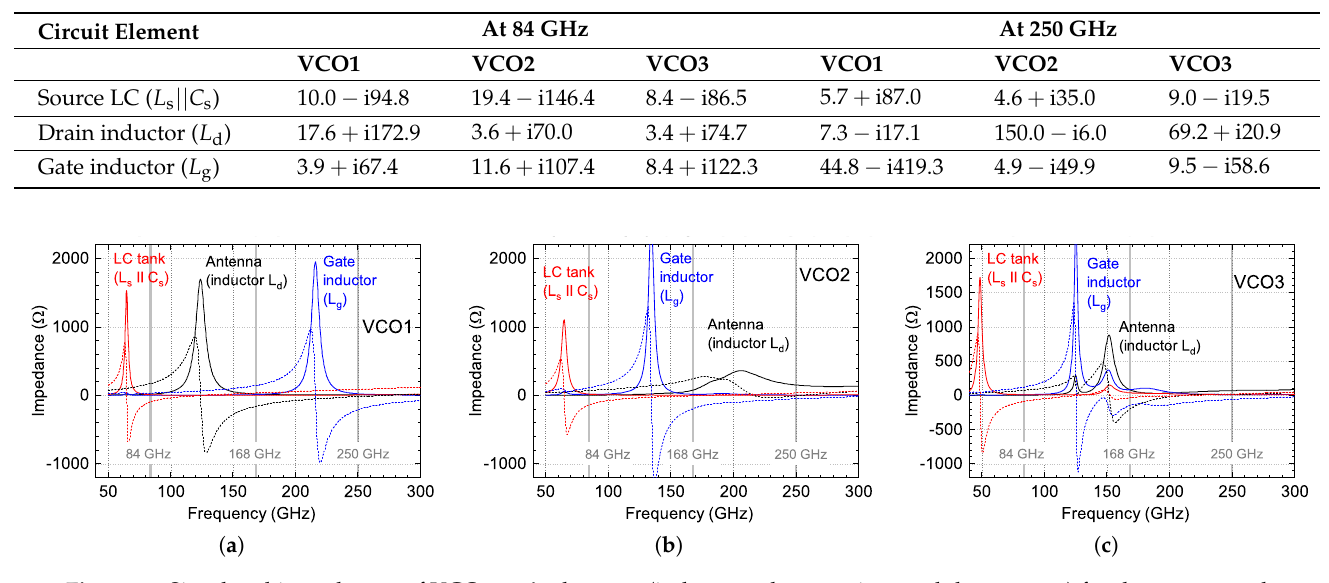
Figure 5. Simulated impedances of VCO core’s elements (inductors, the capacitor, and the antenna) for three proposed device implementations: ( a )—for VCO1, ( b )—for VCO2, and ( c )—for VCO3. The solid lines—a real part, the dashed lines—an imaginary part of the impedance. The vertical gray lines correspond to fundamental (84 GHz), second (168 GHz), and third (250 GHz) oscillation